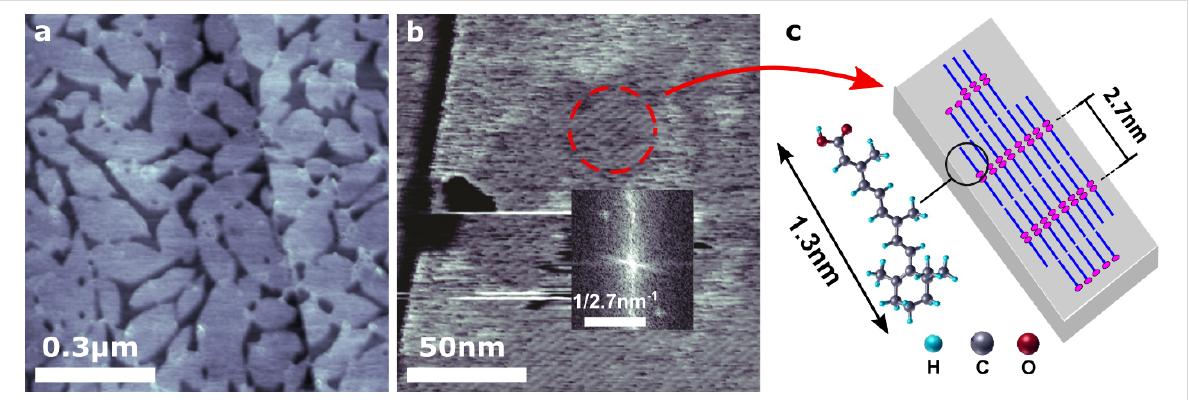
Figure 1: Morphological and structural characterization of the retinoic acid (RA)–graphene hybrid system. (a) Atomic force microscopy topographic image of a RA self-assembled monolayer, partially covering a graphite microplate substrate. (b) High-resolution AFM image (adhesion channel in peak force mode – see Experimental section) of the RA monolayer. The inset shows its fast Fourier transform, evidencing well-defined periodical RA ripples (periodicity: 2.7 ± 0.1 nm). (c) Schematic representation of RA molecule, which is 1.3 nm long, and its proposed configuration atop graphene. The dashed red circle in b) highlights the self-assembled structure and enables a direct comparison with